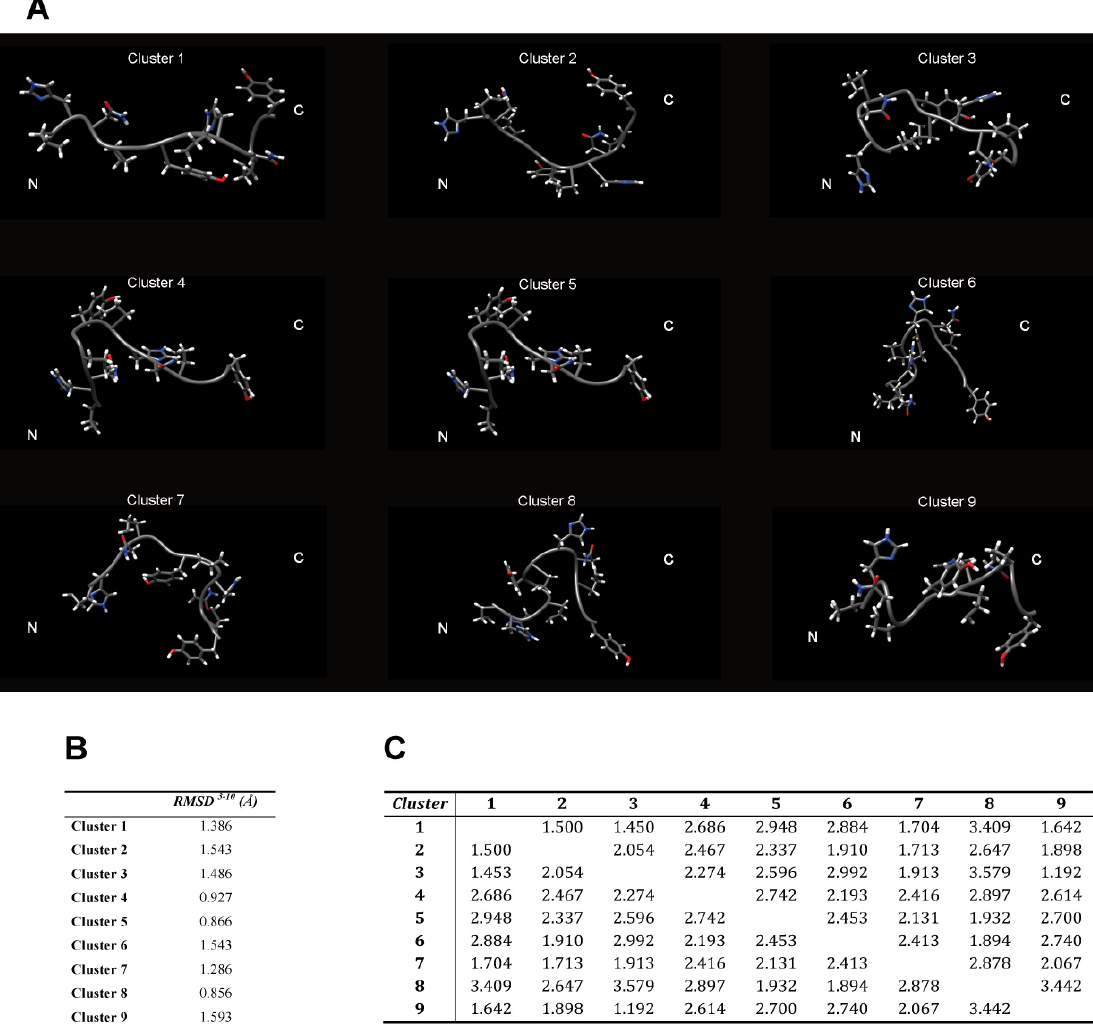
Figure 5. ( A ) The representative conformer from the final Ensemble of 2-HexaPY for each of the nine clusters based on backbone heavy atoms RMSD. The root mean square distributions for backbone heavy atoms of the residues 3–10 with respect to the mean coordinate position within ( B ) and between ( C ) each cluster is also